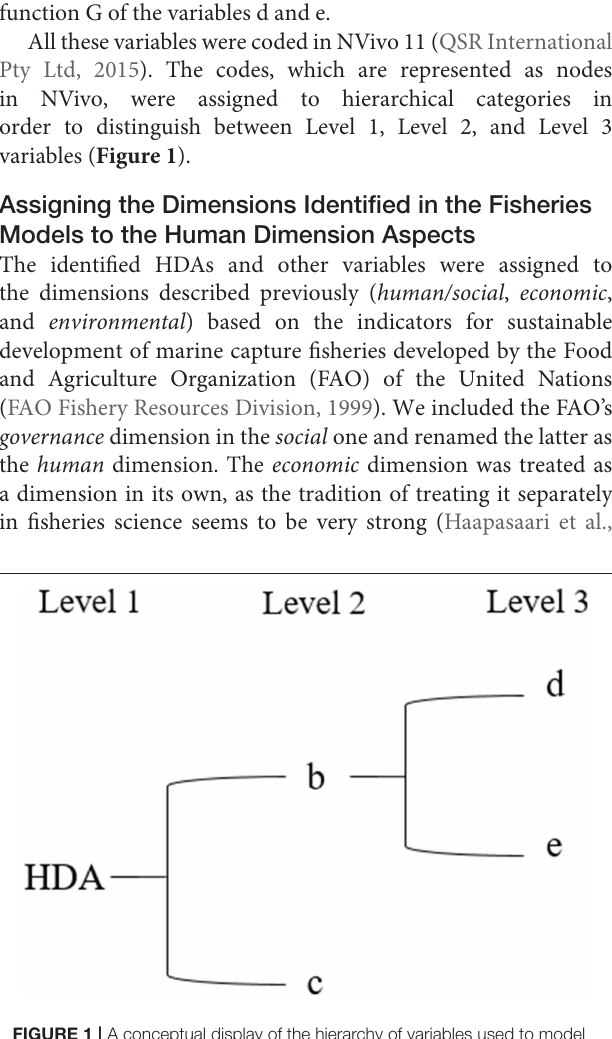
FIGURE 1 | A conceptual display of the hierarchy of variables used to model the main Human Dimension Aspects (HDA) of the human dimension fisheries models. Level 1 represents the main HDA, and Levels 2 and 3 represent the variables (b,c and d,e) that were used in a functional relationship to model the